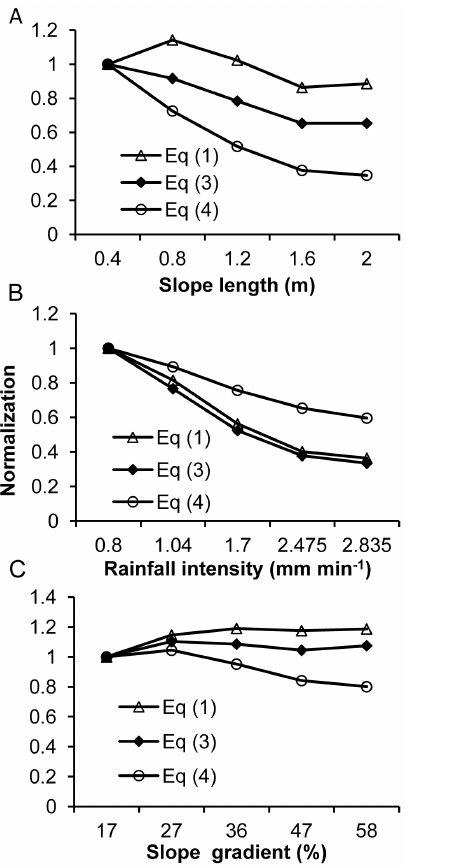
Figure 2. Normalized interrill erodibilities. Variations in interrill erodibility for the three equations for different slope lengths (A), rainfall intensities (B), and slope gradients (C), normalized to the lowest values of the independent